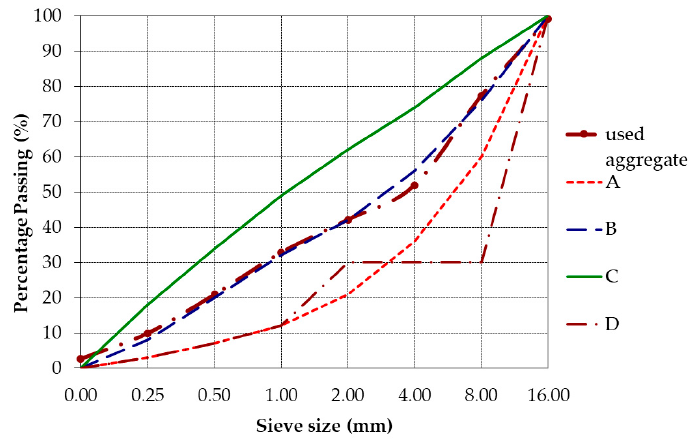
Figure 1. Particle size distribution of aggregates.